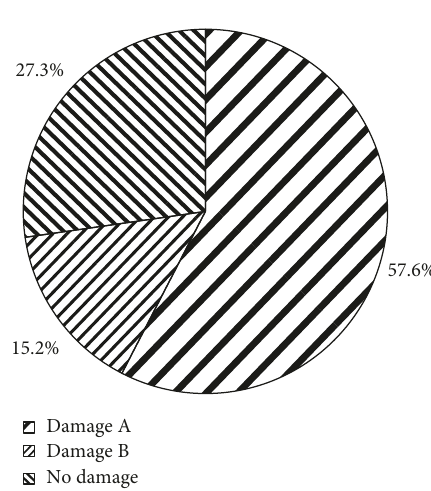
Figure 15: Distribution of damage/deterioration in conditioned GFRP reinforcing